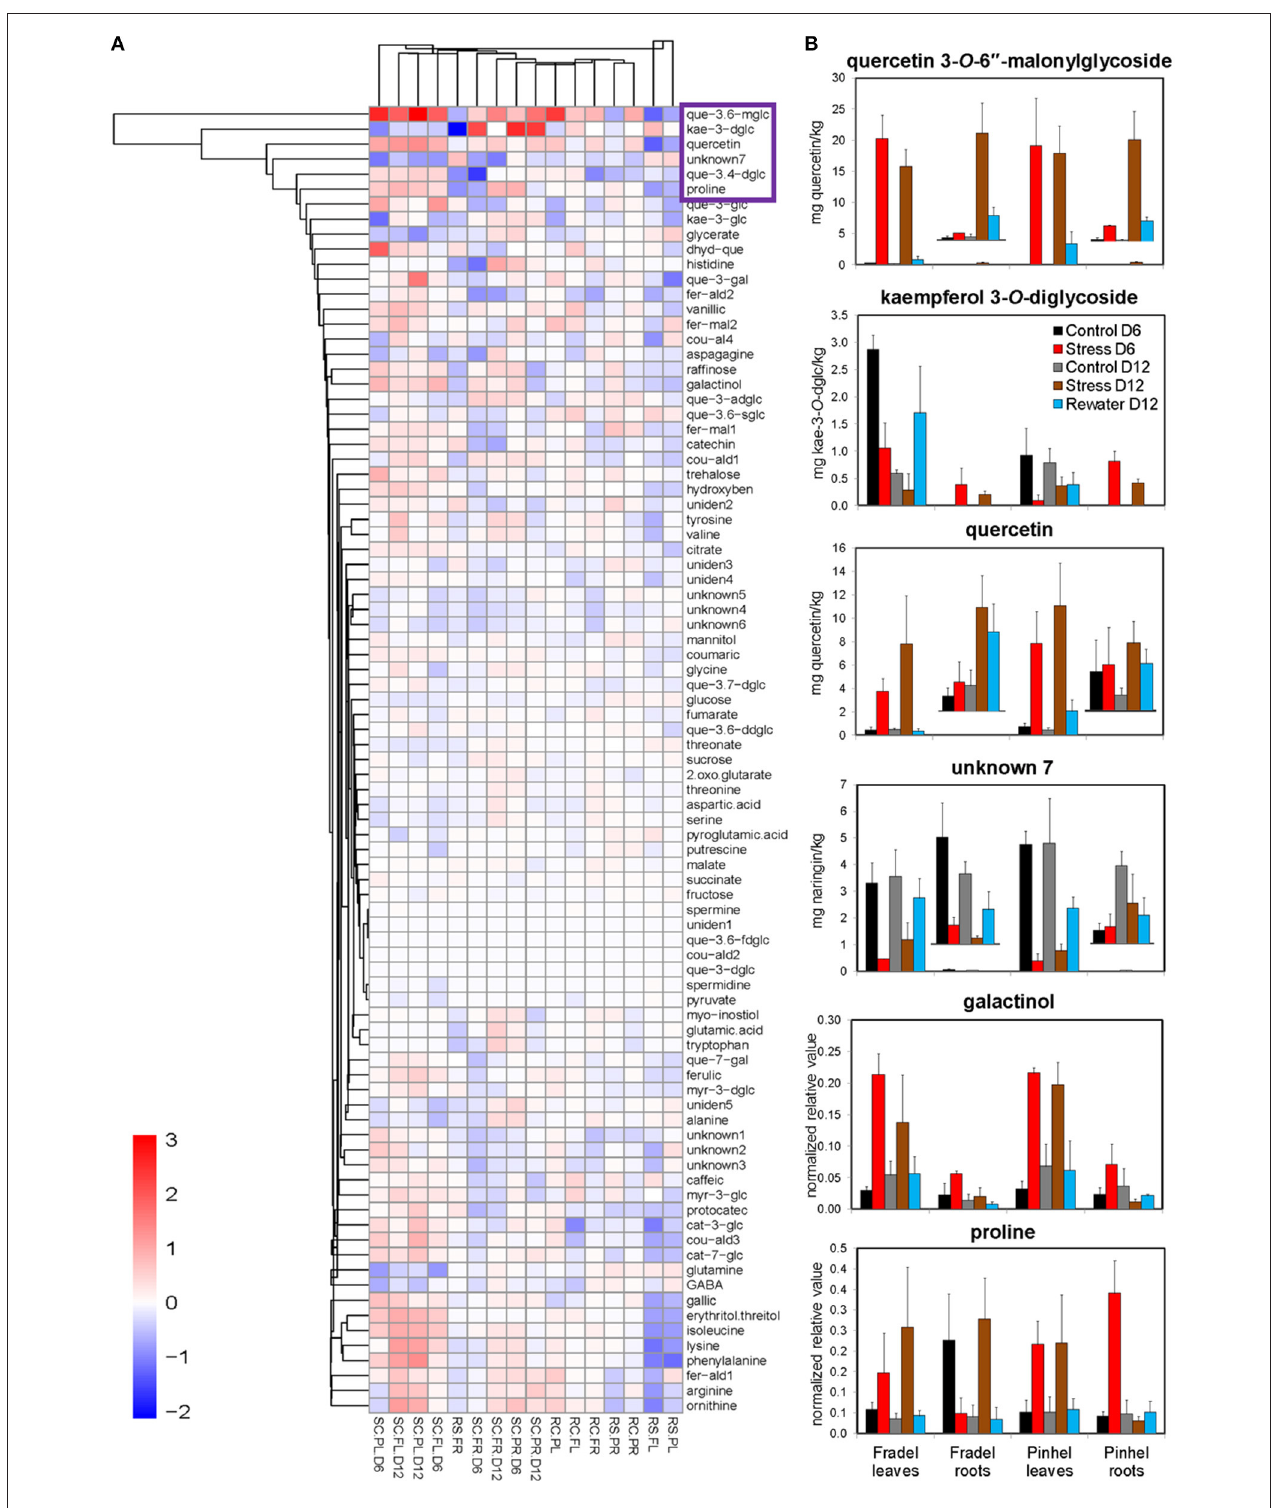
FIGURE 5 | Key metabolites involved in osmoadaptation in cowpea during a drought-rewatering course. (A) Clustering used complete agglomeration and Manhattan distance. Each comparison is abbreviated and shown as a single column. The first two letters in the abbreviation indicate the treatments: SC = log(stress/control), RS = log(rewater/stress), and RC = log(rewater/control). The middle two letters indicate cultivars: PL for Pinhel leaves, PR for Pinhel roots, FL for Fradel leaves, and FR for Fradel roots. D indicates the duration of drought stress without rewatering: D6 and D12 for 6 and 12 days, respectively. The complete names for secondary metabolites can be retrieved from Supplementary Table 3 . (B) Plots of the six drought-responsive compounds highlighted by all statistical tests, with five clustered in the purple box in the heatmap ( n = 4 or 6; error bars = SD).